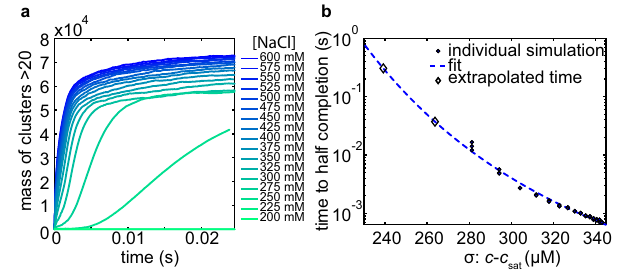
Fig. 8 Simulations of A1-LCD classical homogeneous nucleation rates. a Nucleation is represented as the mass of clusters in the simulation with greater than 20 monomers versus simulation time. Each trace is the average of three independent simulations. b The time at half completion in a is used as a proxy for nucleation time and is plotted versus the degree of supersaturation in the